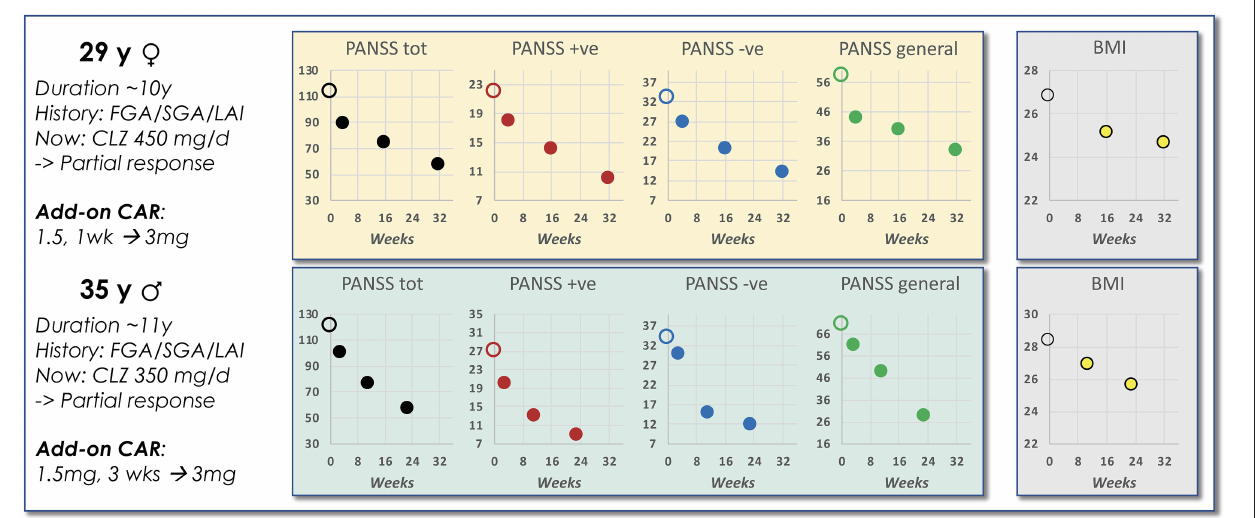
FIGURE 7 | Data from a case report of CAR add-on to CLZ treatment. Shown is a brief schizophrenia treatment history of a female and a male patient prior to APP add-on with CAR to ongoing CLZ treatment. The accompanying graphs illustrate PANSS scoring and BMI observations evolving over time following start of the CAR add-on intervention [data extracted from De Berardis et al. ( 16)].